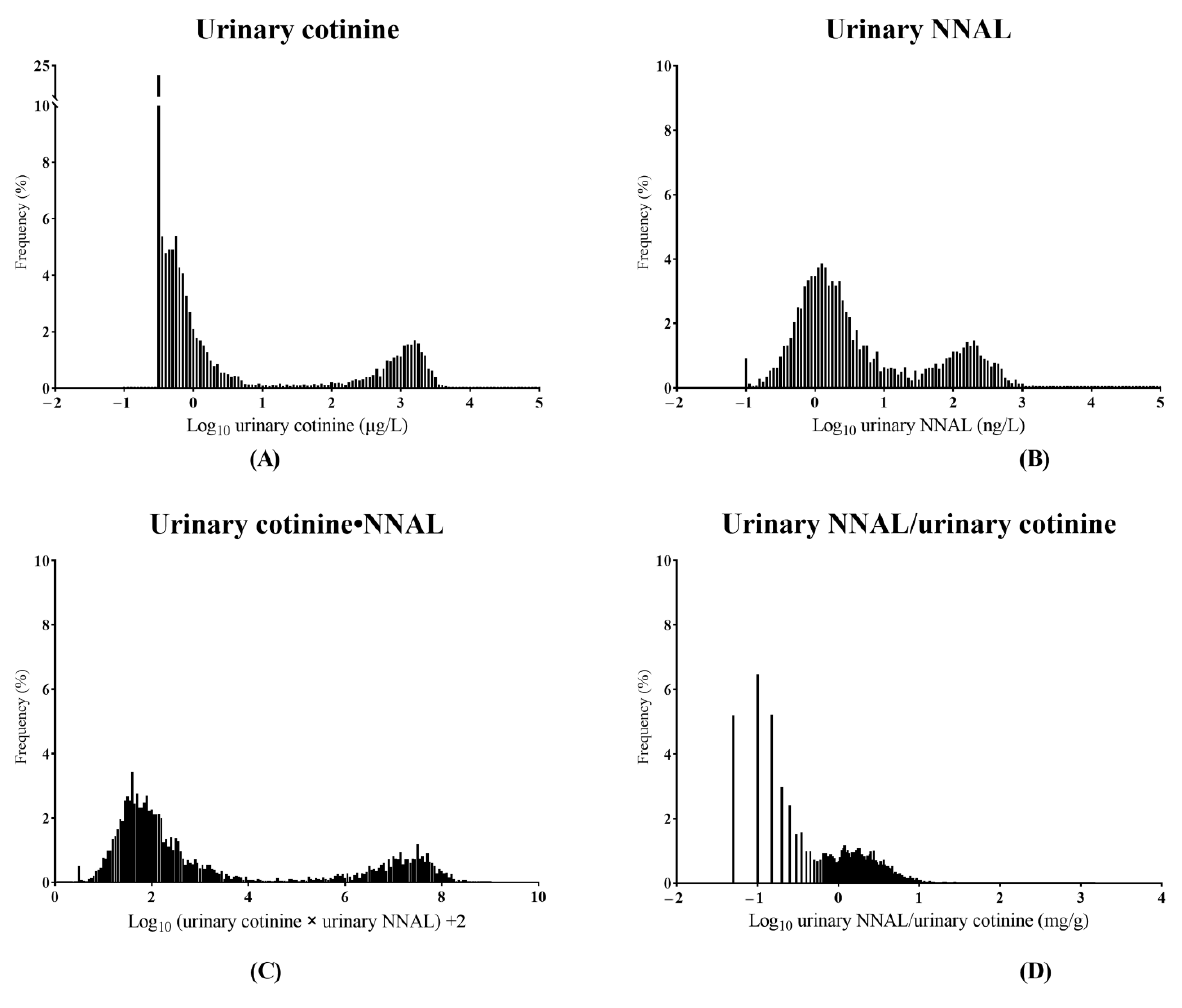
Figure 3. The distributions of four urinary biomarkers from non-smokers from total participants. Urinary cotinine ( A ), NNAL ( B ), cotinine∙NNAL ( C ), and NNAL/cotinine ( D ). NNAL = 4-(methyl- pants. Urinary cotinine ( A ), NNAL ( B ), cotinine · NNAL ( C ), and NNAL/cotinine ( D ). NNAL = 4- nitrosamino)-1-(3-pyridyl)-1-butanol .